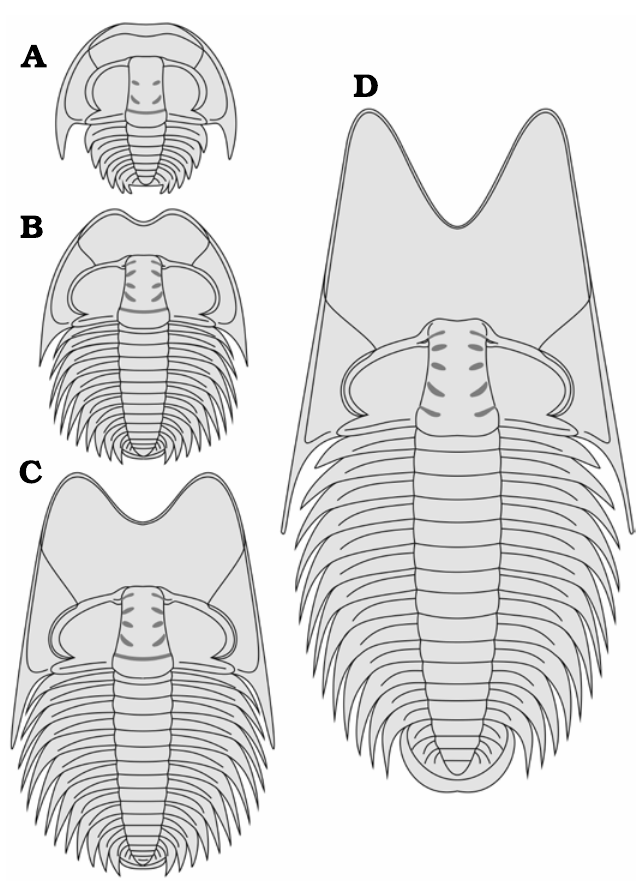
Fig. 6. Reconstructions of the dorsal exoskeleton and life cycle of Phanta­ spis auritus gen. et sp. nov. from the Cambrian (Miaolingian, Wuliuan) Mantou Formation, Longgang section, Shandong Province, North